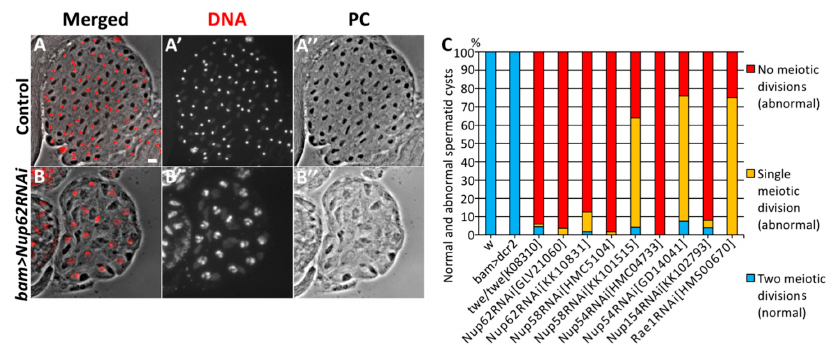
Figure 1. Abnormal cysts consisting 25% and 50% of the normal spermatids generated from spermatocytes depleted of Nup62 complex components. ( A , B ) Phase contrast micrographs of a single intact cyst composed of spermatids at the onion stage and slightly later stage. ( A ) A normal spermatid cyst contained 64 cells after the completion of meiosis II, which were generated by two consecutive meiotic divisions of 16 premeiotic spermatocytes. Every cell possesses a single nucleus (stained with DAPI) and a single Nebenkern, which is a mitochondrial derivative. ( B ) An intact cyst consisting of only 16 spermatids. Each spermatid possesses a larger nucleus and a single Nebenkern. The presence of the abnormal post-meiotic cyst suggests that neither of the meiotic divisions had occurred in the relevant cyst consisting of 16 premeiotic spermatocytes. Nuclei stained with DAPI are colored in red ( A , B ) and white ( A’ , B’ ). Black round-shaped structures adjacent to nuclei in the spermatids correspond to Nebenkern, a mitochondrial derivative ( A , A” , B , B” ). Bar: 10 μ m. ( C ) Frequencies of abnormal spermatid cysts, consisting of 64 (normal), 32 (abnormal, generated by either of meiotic